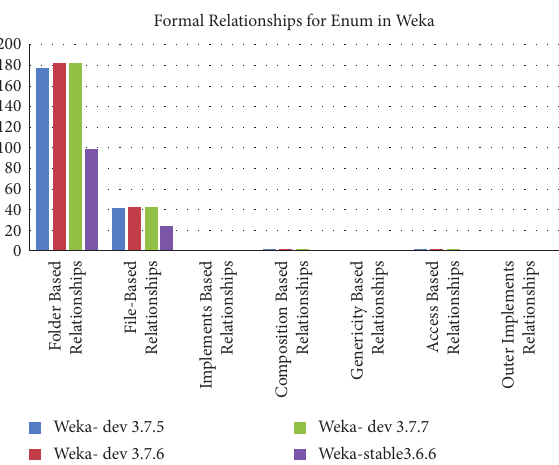
Figure 24: Count of formal relationships for enum in